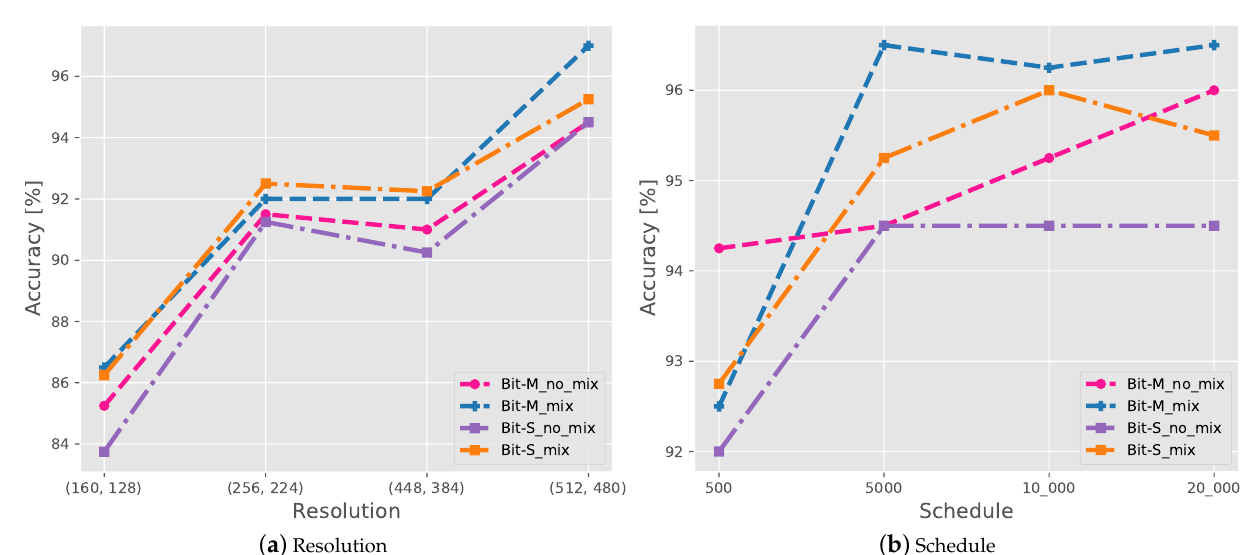
Figure 4. Test accuracy of COVIDx CXR-2 with various hyperparameters. ( a ) Resolution. ( b )